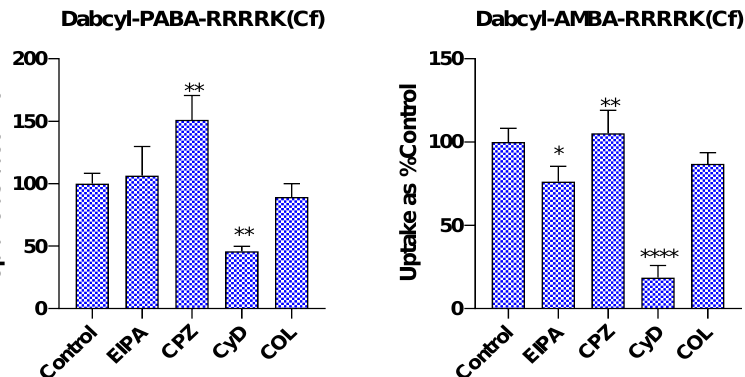
Figure 8. Effect of endocytosis inhibitors on the cellular uptake of peptide conjugates. MDA-MB-231 cells were pretreated with inhibitors EIPA (50 µ M), CPZ (30 µ M), CyD (5 mM) and COL (20 µ M) for 30 min, the cells were then treated with the peptide conjugates (5 µ M) for 90 min. Significant difference from control was measured using student’s t test (* p <0.05, ** p < 0.01and **** p < 0.0001).